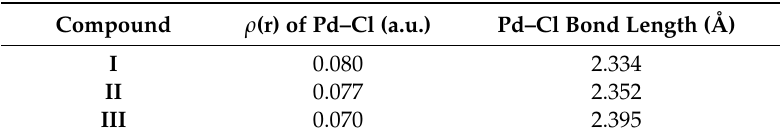
Figure 3. Model palladacycles I – III studied to investigate the trans influence. Table 2. The electron density ρ ( r ) and Pd–Cl bond lengths.